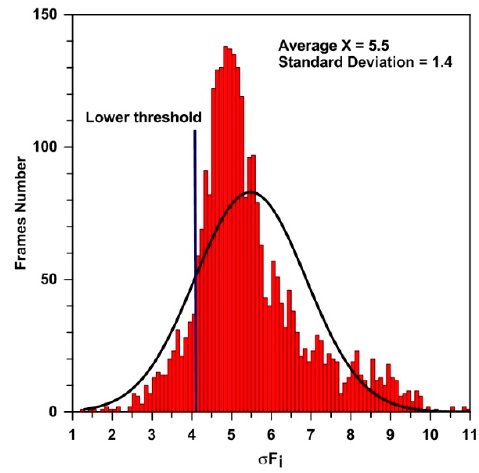
Figure 8. Frequency distribution of Standard Deviation values of IR frames temperatures ( σ F) acquired at SF1 station. The line ‘Lower Threshold’, which is defined by the relation (1) with c parameter equal to 1, splits good-quality frames (on the right of the line) and low-quality frames (on the left of the line).